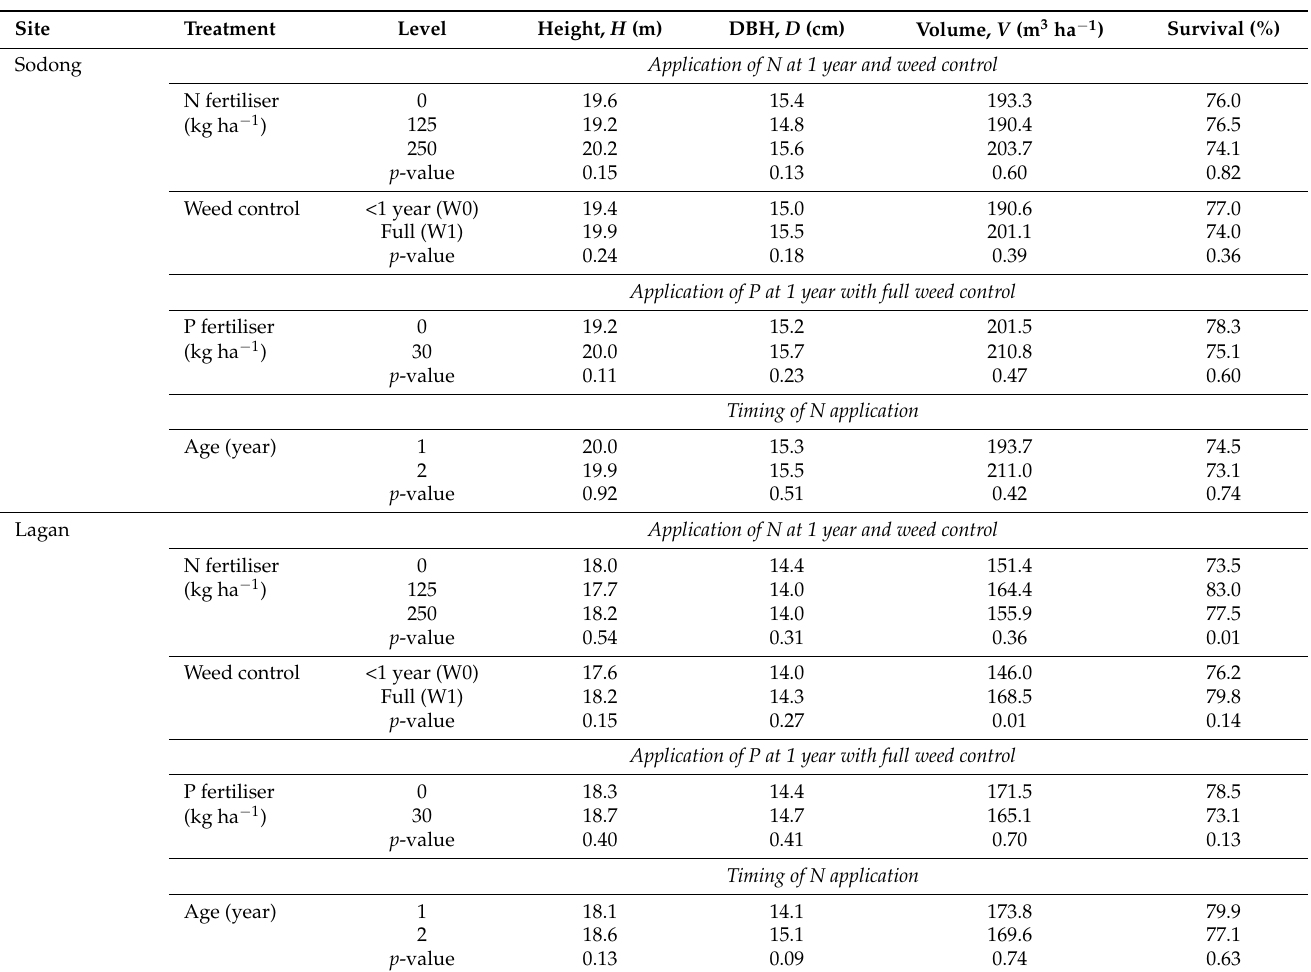
Table 3. Growth and survival of Eucalyptus pellita at mid-rotation in the core experiment at age 6 years. Site